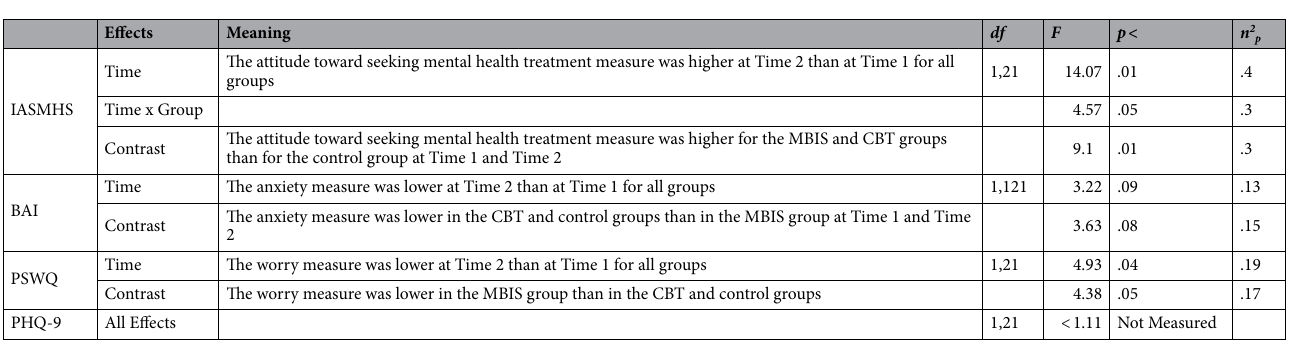
Figure 1. ( a ) Worry and ( b ) anxiety levels before and after the interventions.